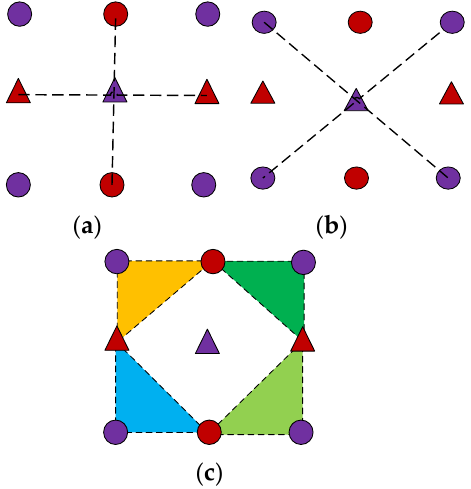
Figure 4. Eight types of the triangular tangent planes through x ( a ) two of the common edges from the four tangent plane ( R ); ( b ) two of the common edges from the four tangent plane ( P ); ( c ) four of the tangent planes through mixed neighbors.